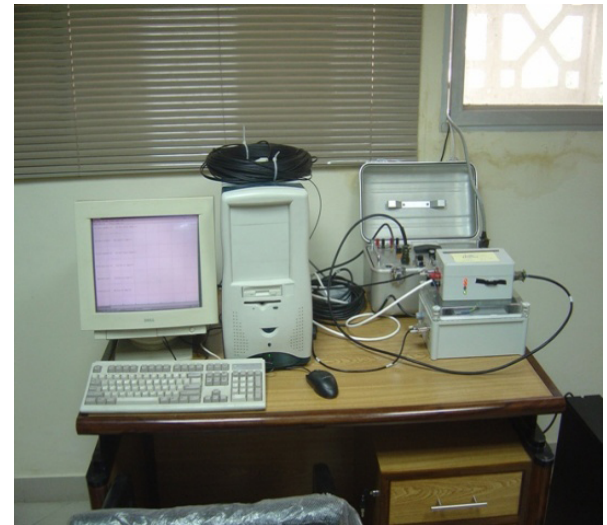
Figure 7. The INDIGO